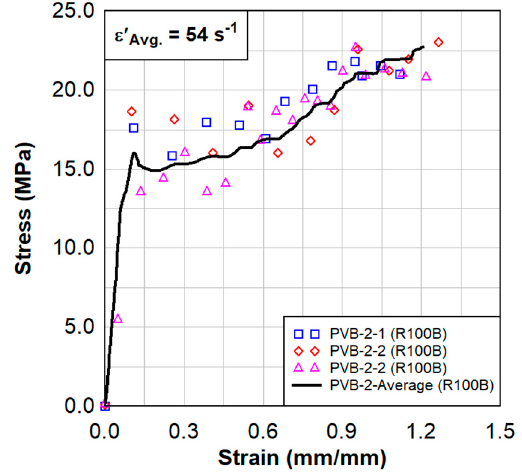
Figure 8. Dynamic tensile test results from three samples of radiated PVB − 2 specimens.